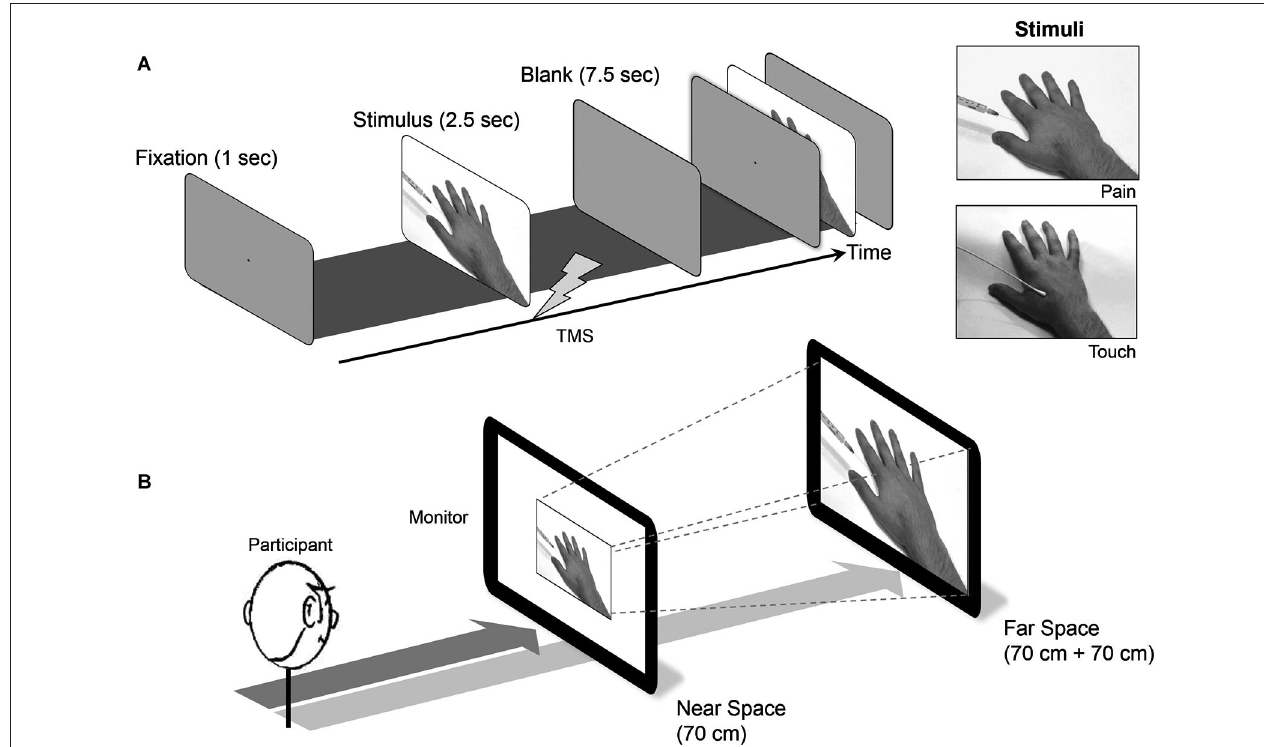
FIGURE 1 | (A) The stimulation procedure. (B) The monitor distances: the peripersonal (near) space was fixed at 70 cm and the extrapersonal (far) space was at 140 cm distance, by adjusting a 19 inch-monitor position from the